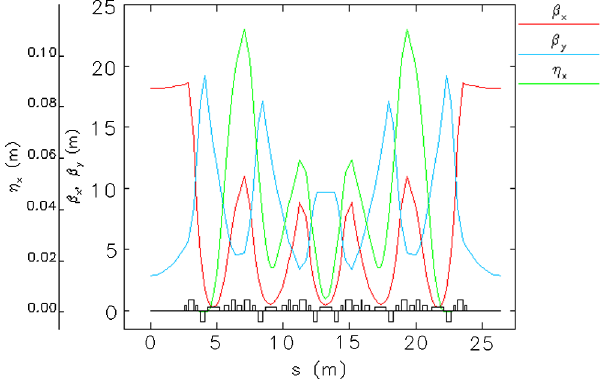
FIG. 2. The optical functions in a super period of the storage ring.